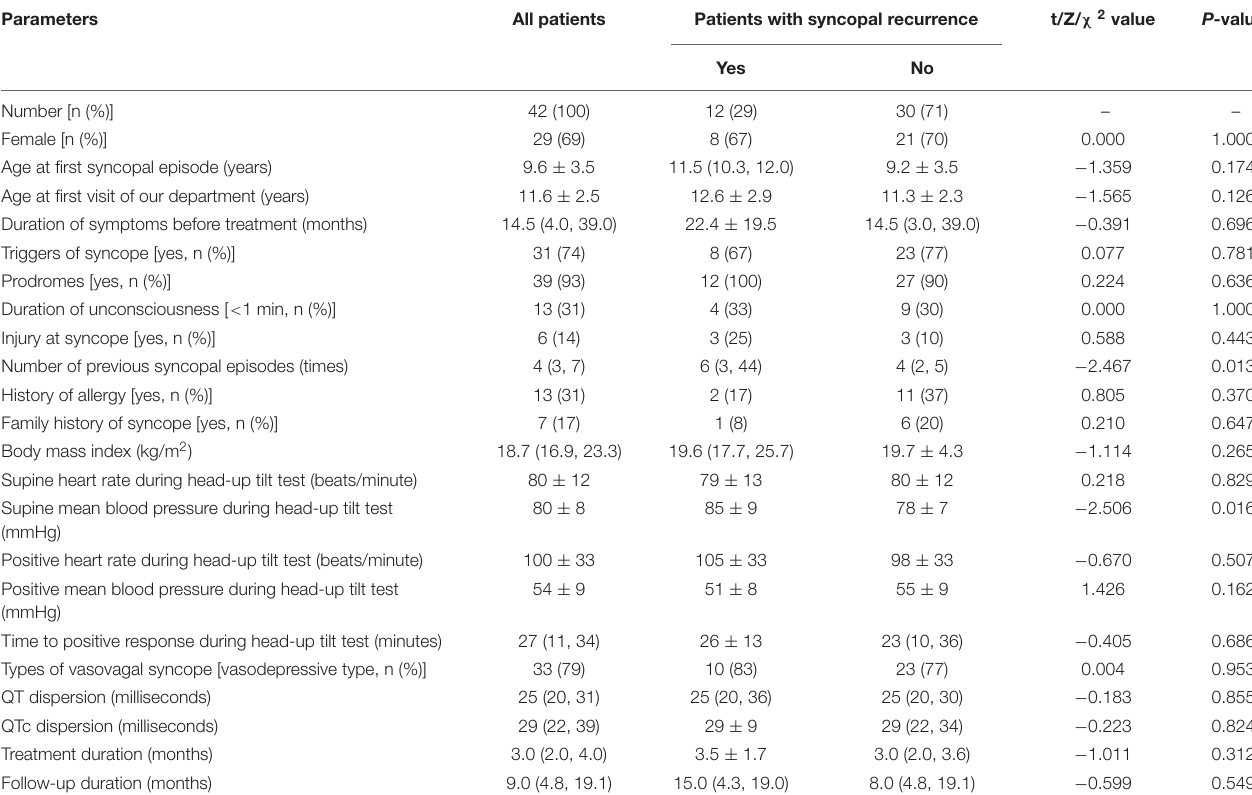
TABLE 1 | The baseline characteristics of the study population and comparisons of patients with and without syncopal recurrence. Parameters All patients Patients with syncopal